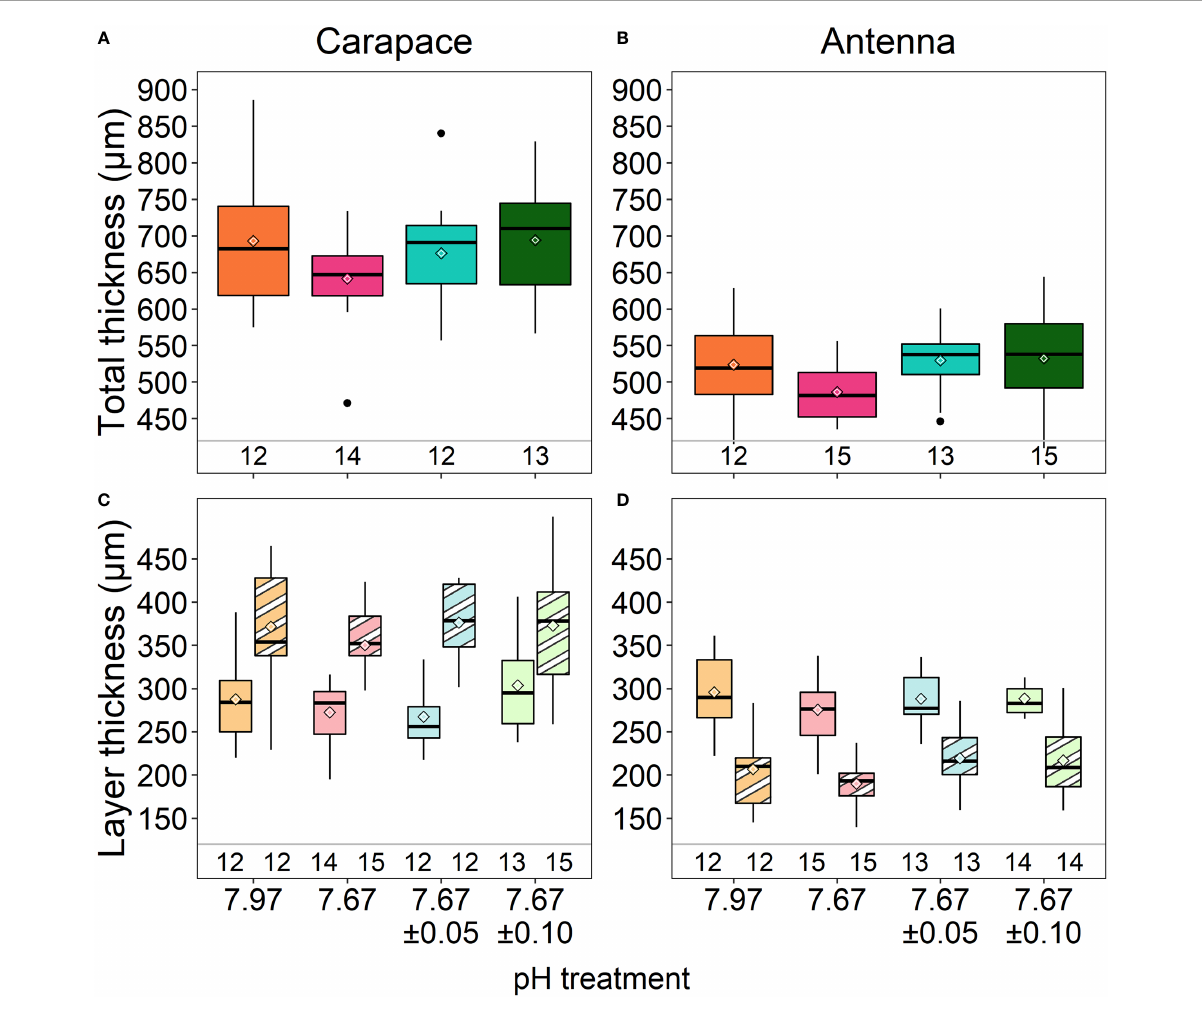
FIGURE 2 Total cuticle thickness of the carapace (A) and antennae (B) and cuticle layer thickness of the carapace (C) and antennae (D) . Exocuticle layers are right boxes of each treatment (stripes in C, D ) and endocuticle layers are left boxes of each treatment (solids in C , D ). There were no differences in total thickness or layer thickness of the carapace or antennae among treatments. Box boundaries are the first and third quartiles, whiskers are 1.5 times the interquartile range, the center line is the median, black and white diamonds are the mean, and outliers are solid dots. Values on the bottom of panels denote sample